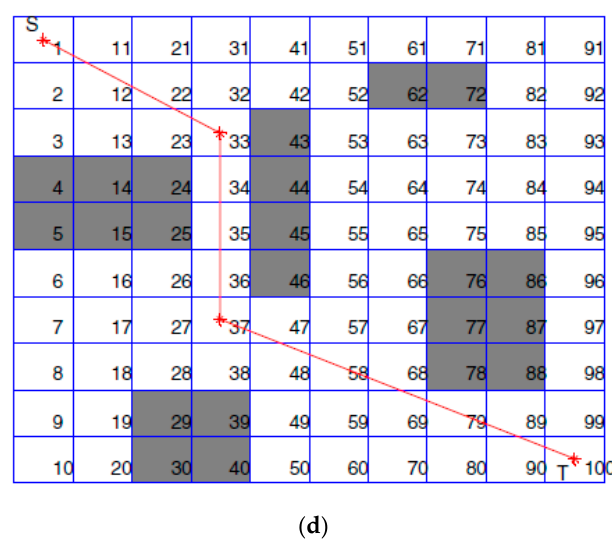
Figure 16. The best path achieved by ( a ) aging-based ant colony optimization (ABACO), ( b ) the genetic algorithm (GA) [31], ( c ) pattern search (PS) [31], and ( d ) particle swarm optimization (PSO) [31] (Map 1).